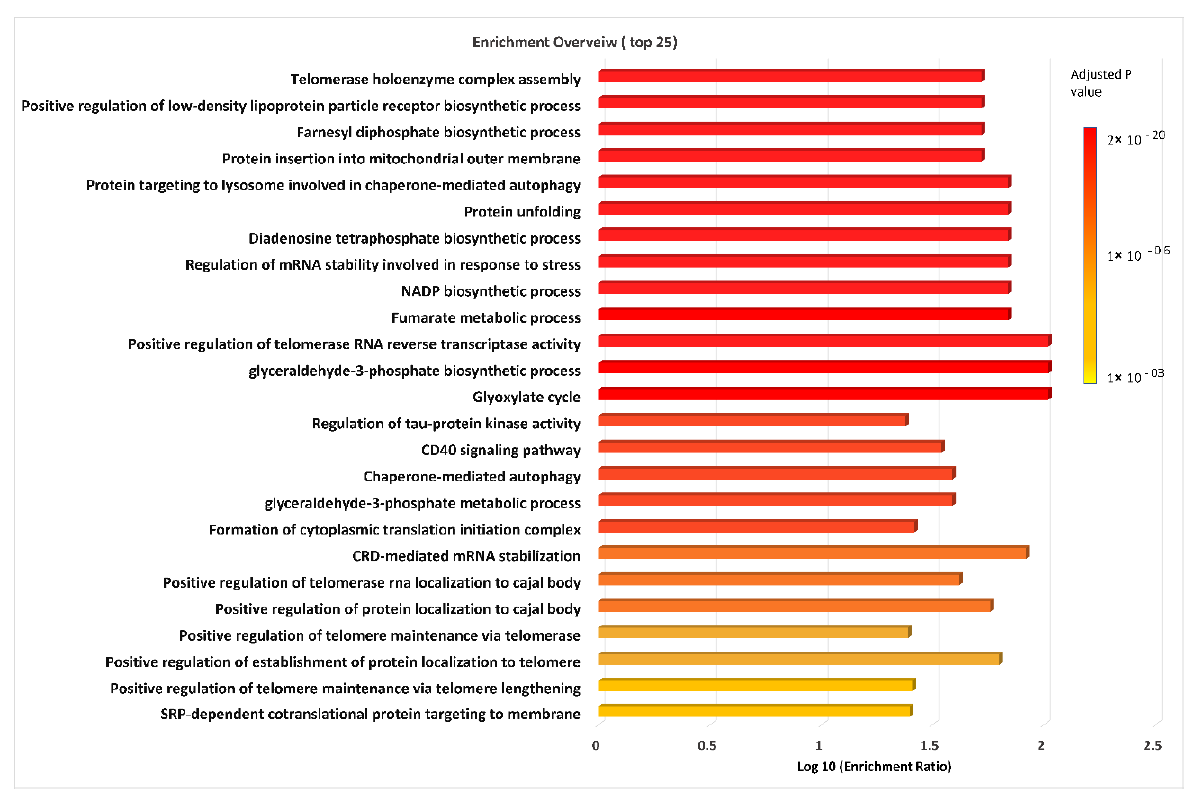
Figure 6. Visualization of enrichment analysis for gene ontology biological process (GOBP) terms using String software version 11.5. The graph shows top 25 significant GOBP terms colored according to their respective enrichment p values.